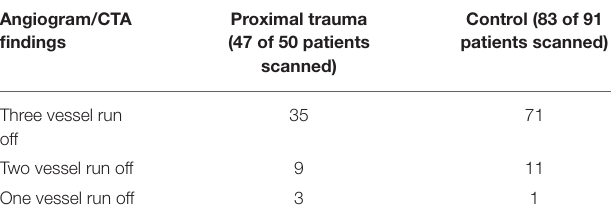
TABLE 2 | Pre-operative arterial patency of lower